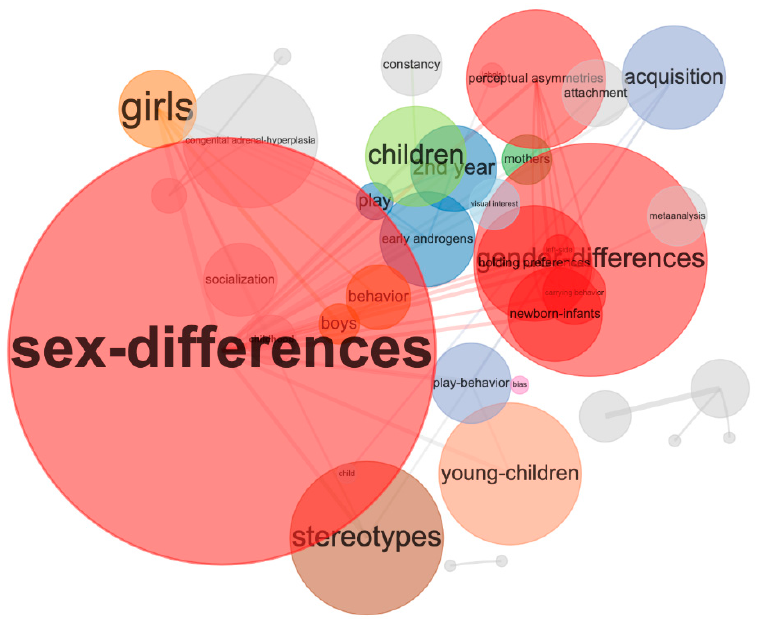
Figure 8. Co-occurrence network of concepts.